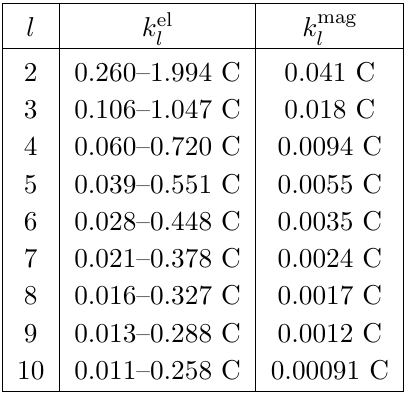
Table 1 . Electric and magnetic Love number as function of compactness C